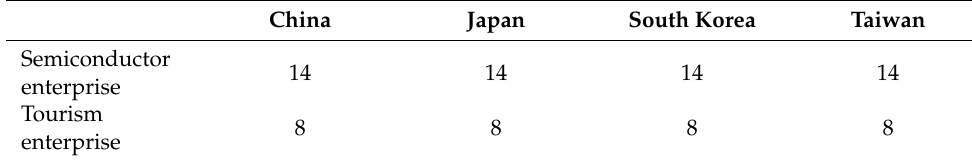
Table 2. Enterprise distribution relative